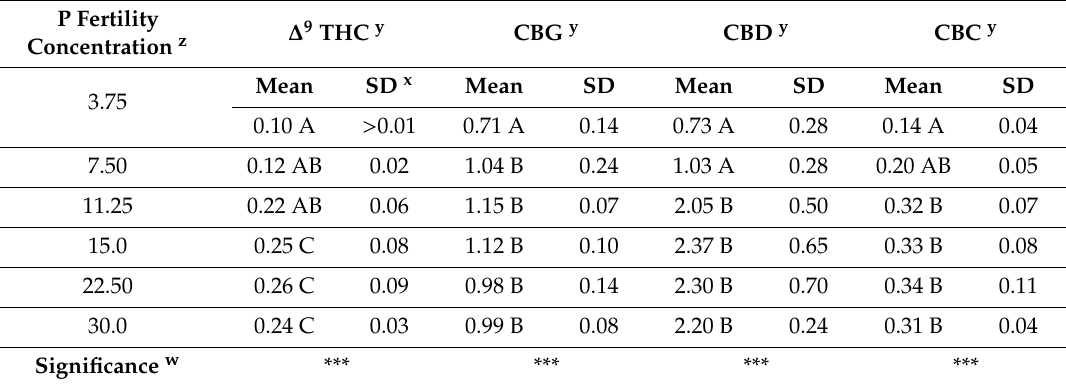
Table 7. The impacts of phosphorus (P) fertility on active cannabinoid pools of C. sativa “BaOx” floral material after eight weeks of critical night length (CNL)